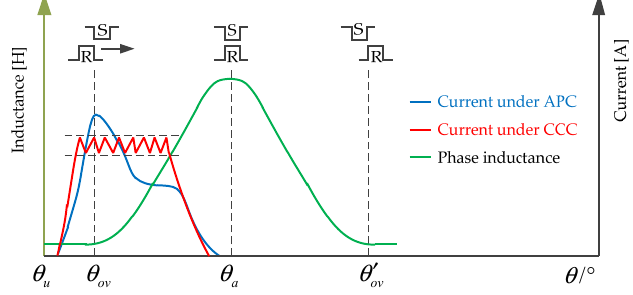
Figure 6. Current waveforms for different control algorithms and inductor cycles.